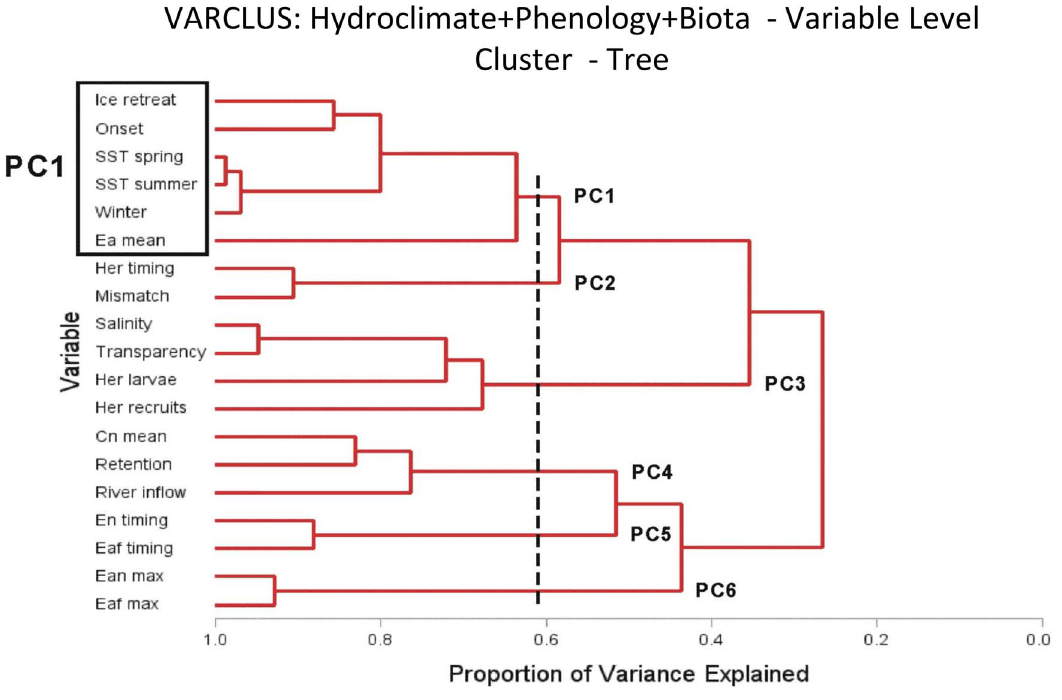
Figure 5. Cluster-tree combining most closely related variables estimated from scree test at Eigen values. Closest variable groups are indicated with the vertical line crossing the x-axis. In x-axis the proportion of variance explained within the formed single group is presented.